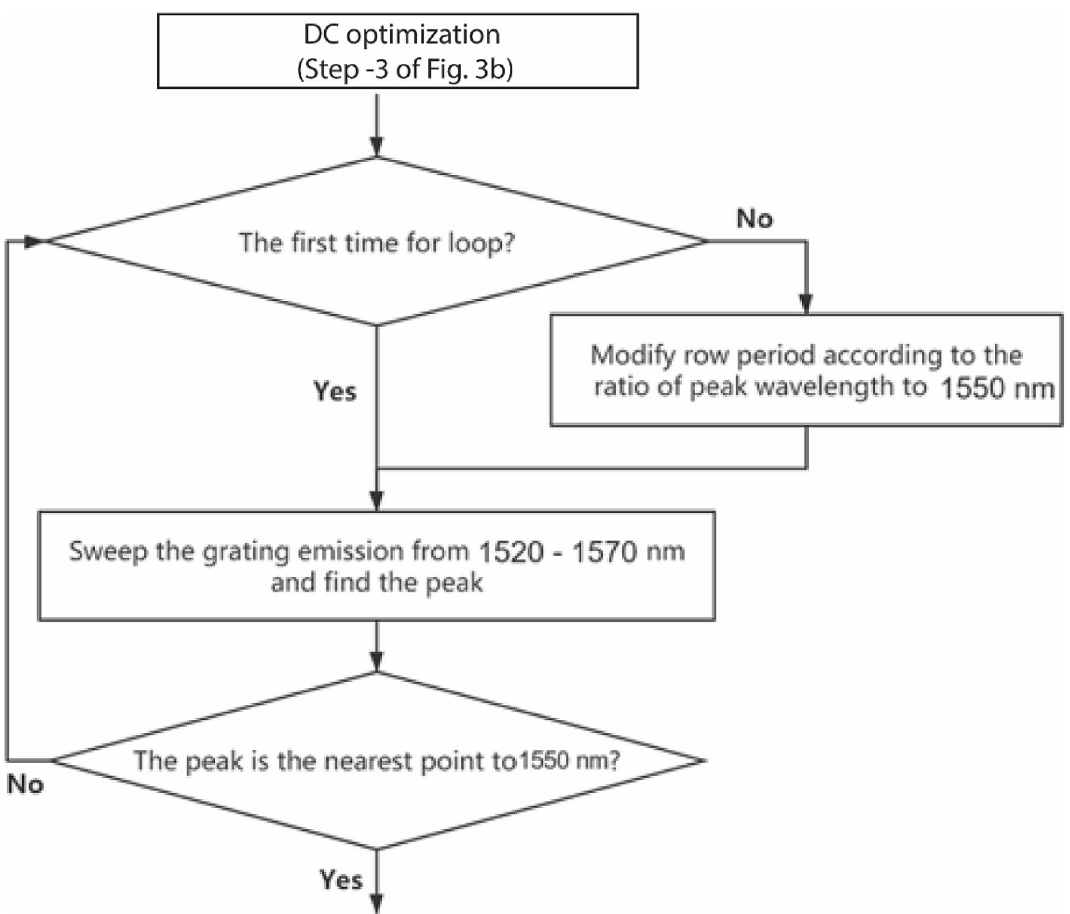
Figure 5. Detailed control flow chart of the “Modify groove period to stabilize the center wavelength of emission” in Fig.